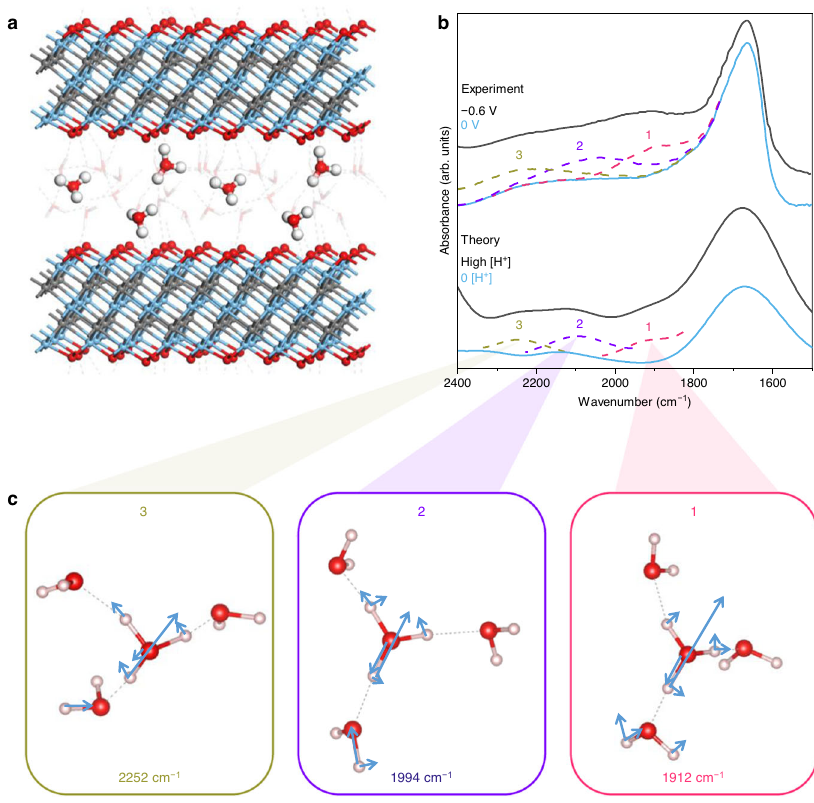
Fig. 3 | Vibrational signature of hydrated protons in the interlayer space of Ti 3 C 2 T x MXene. a The structure of three protons con fi ned within the MXene interlayer space. Two unit cells are shown. b Top: Operando FTIR spectra at 0V (blue)and − 0.6V(black)in0.1MH 2 SO 4 referencedtothebaregraphene-coveredSi IRErepresent low and high proton content, respectively. The dotted green, purple andredlinesshowpeakcomponents1,2and3superimposedontothespectrumat 0V.Bottom:CalculatedspectraoftwolayersofwaterintheMXeneinterlayerspace